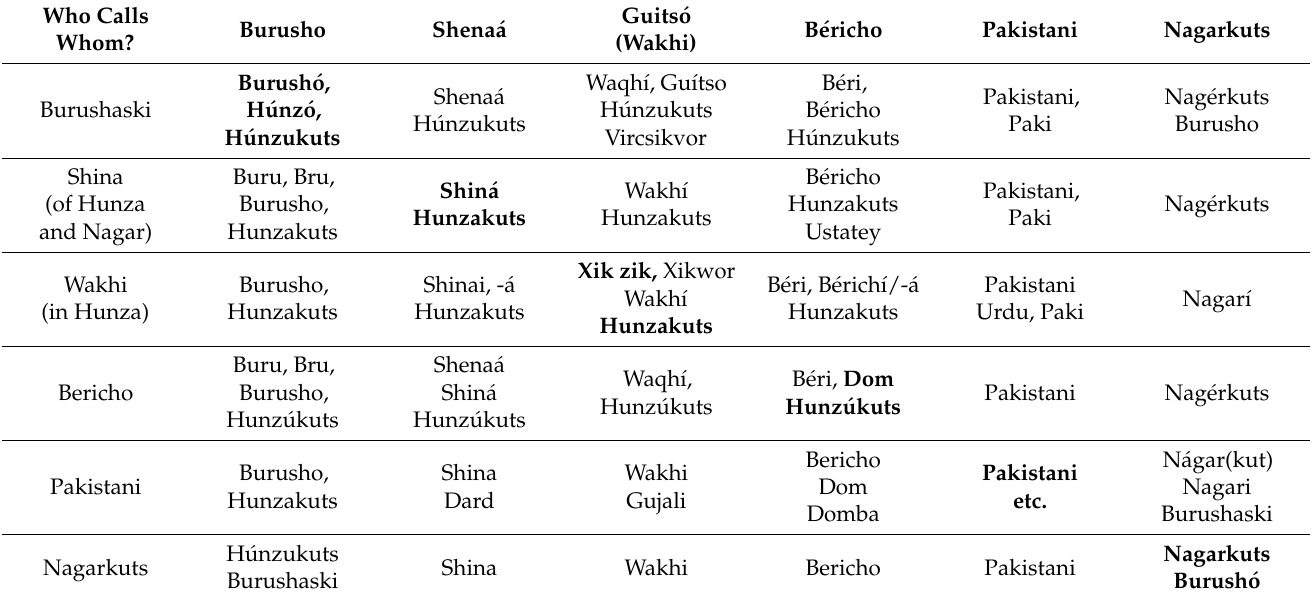
Table 1. Situation-dependent ethnic terminology in Hunza (according to the language groups). The bold highlights the self-referential ethnic